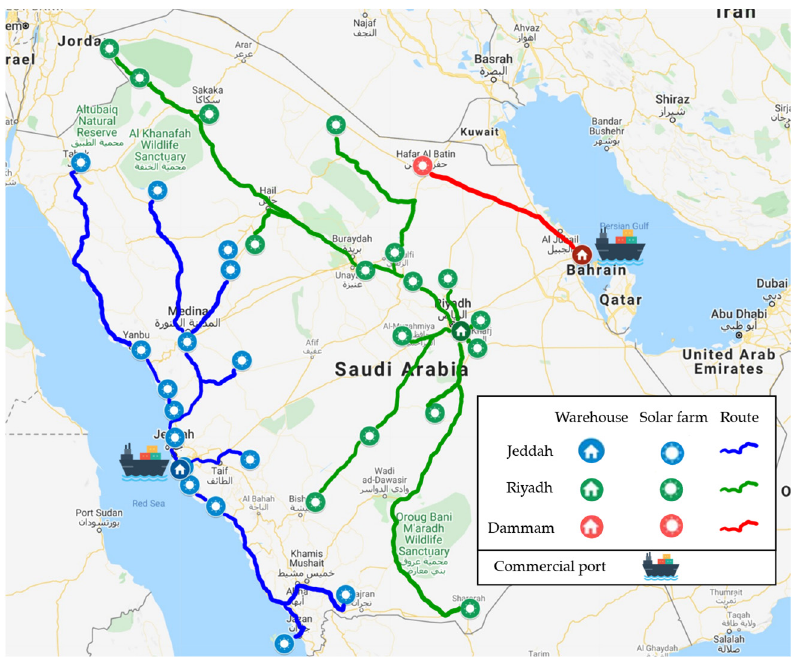
Figure 7. Modelled supply chain network to support distribution of PV modules to appropriately selected PV solar farms as constructed in this research’s simulation model. The blue, green and red lines represent the routes for PV modules travelling from Jeddah, Riyadh and Dammam warehouses, respectively. [6,31–33].